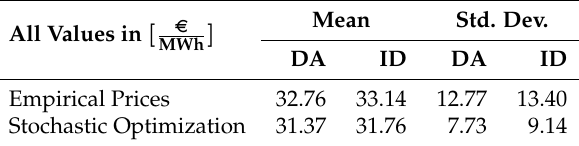
Figure 7. Bivariate distribution of the probability of occurrence of a price spread between DA and ID market due to a forecasting error for empirical data ( top ) and the back-test ( bottom ). Table 1. Comparison of empiric prices and simulated prices from the 2014 backtest (mean and standard deviation)